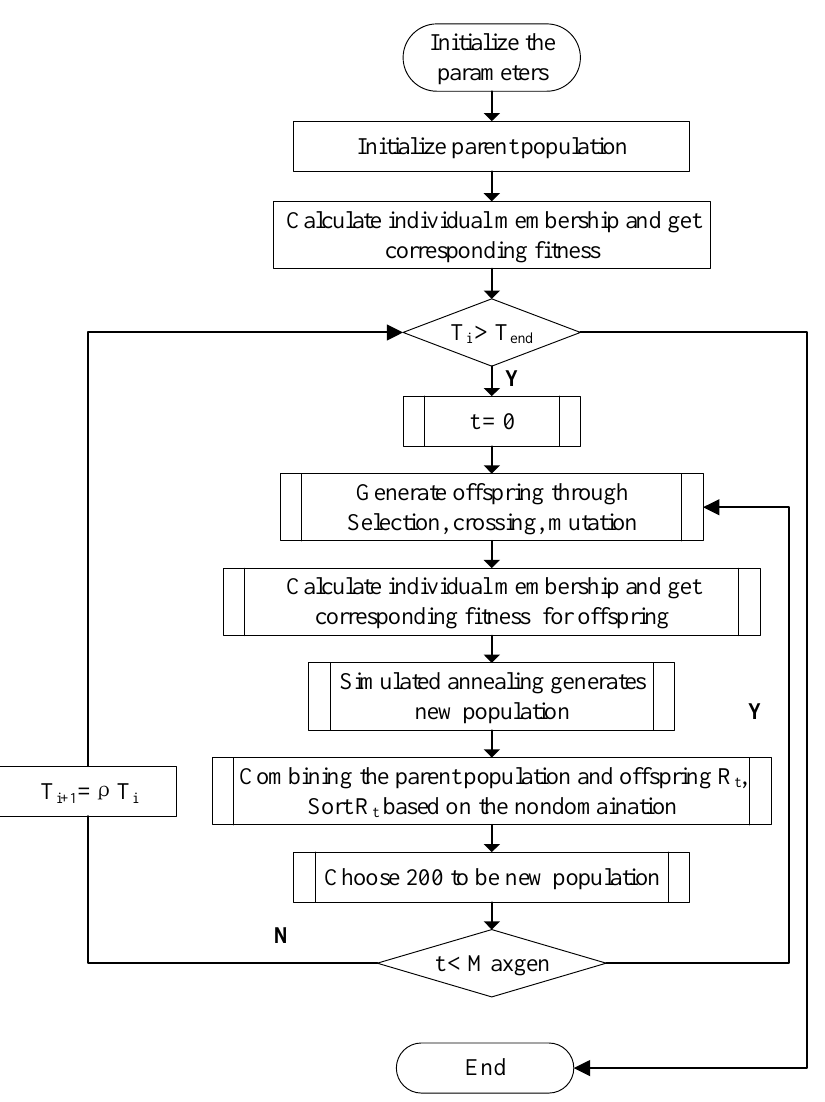
Figure 2. Flow-chart of non-dominated sorting and simulated annealing genetic algorithm (NSSAGA) algorithm.